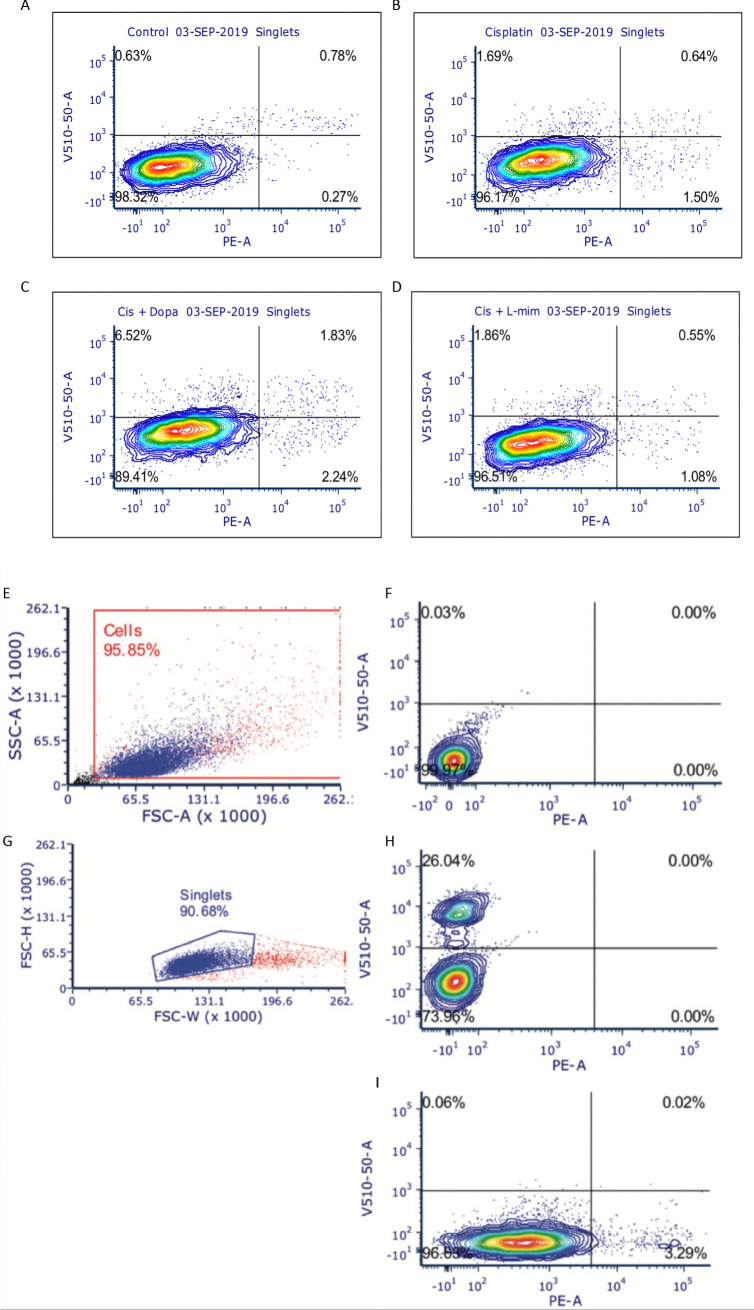
Representative flow plots and gating strategies for the detection of late-stage apoptosis and cell death in SK-N-AS neuroblastoma (NBL) cells.SK-N-AS neuroblastoma (NBL) cells were treated with either vehicle control or either 0.03 mM dopamine or 0.03 mM L-mimosine for 12 hr, were rinsed, then treated with 0.01 mM cisplatin for 48 hrs. Cells were collected, rinsed, and prepared for PE-conjugated Annexin-V/SYTOXBlue flow cytometry. Data were analyzed using BD FACSDiva Software. (A–D) Representative flow plots demonstrating the four quadrants. LL=Annexin-/SYTOX-, LR=Annexin+/SYTOX-, UL=Annexin-/SYTOX+, UR=Annexin+/SYTOX+. (A) Control untreated cells, (B) Cisplatin only, (C) dopamine + cisplatin, (D) L-mimosine + cisplatin. N=4. (E) General gating strategy to identify living and dead cells in sample and to eliminate cell debris. (F) Unstained control cells. (G) Doublet discrimination strategy. (H) Unstained control cells. (I) Gating strategy to identify SYTOX+ dead cells. Representative plots from heat-killed SYTOX+ control cells. (J) Gating strategy to identify Annexin+ cells. Representative flow plot from cells treated with Camptothecin to induce apoptosis.